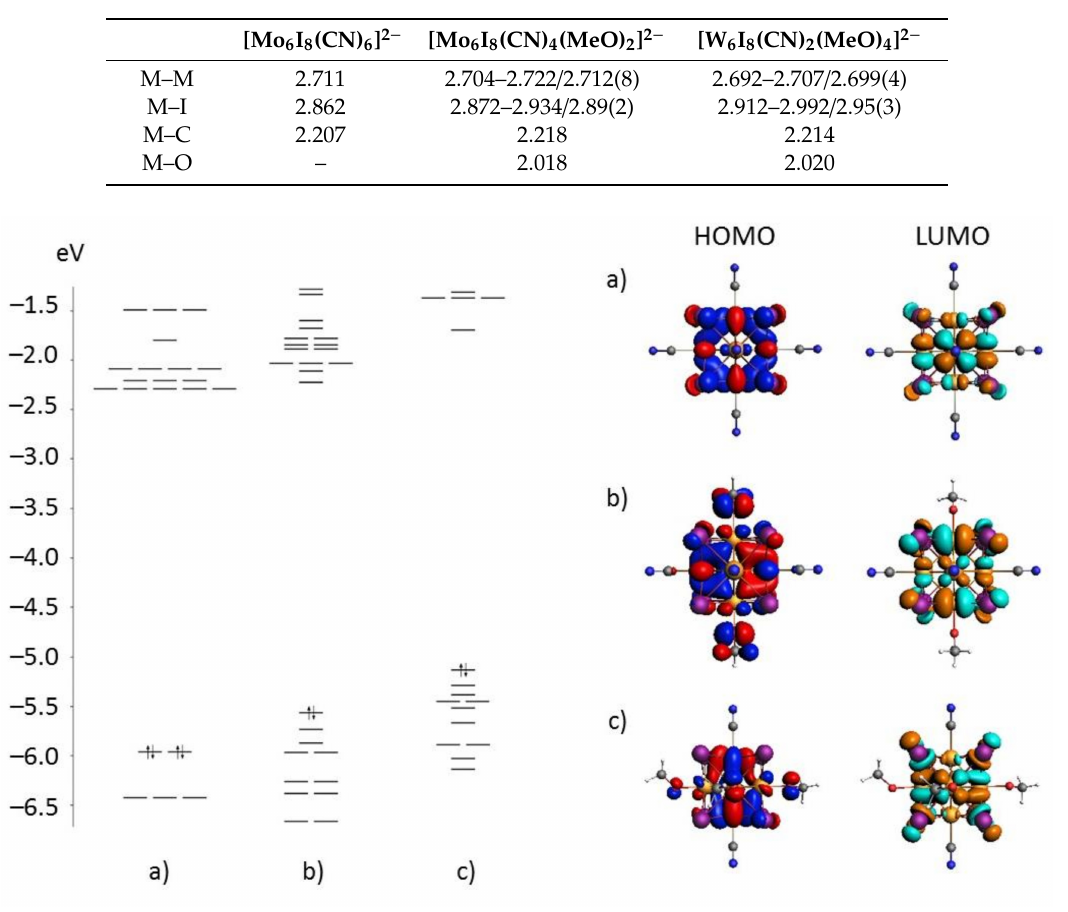
Figure 6. Left: energy level diagrams of the [{Mo 6 I 8 }(CN) 6 ] 2 − , trans -[{Mo 6 I 8 }(CN) 4 (MeO) 2 ] 2 − , and trans -[{W 6 I 8 }(CN) 2 (MeO) 4 ] 2 − cluster anions ( a – c , respectively). Right: structure of the HOMOs and LUMOs of the [{Mo 6 I 8 }(CN) 6 ] 2 − , trans -[{Mo 6 I 8 }(CN) 4 (MeO) 2 ] 2 − , and trans -[{W 6 I 8 }(CN) 2 (MeO) 4 ] 2 − cluster anions ( a – c ,